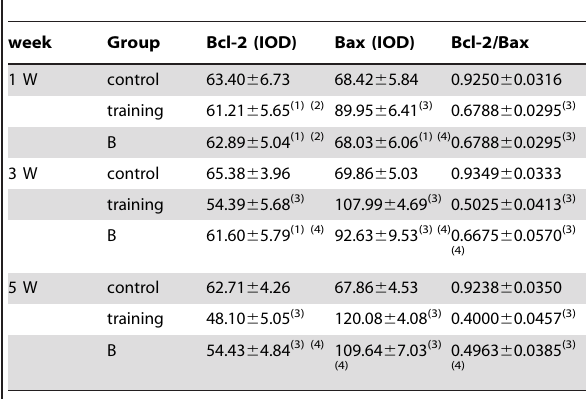
Table 4. Effect of pulse current on the expression of Bcl-2 and